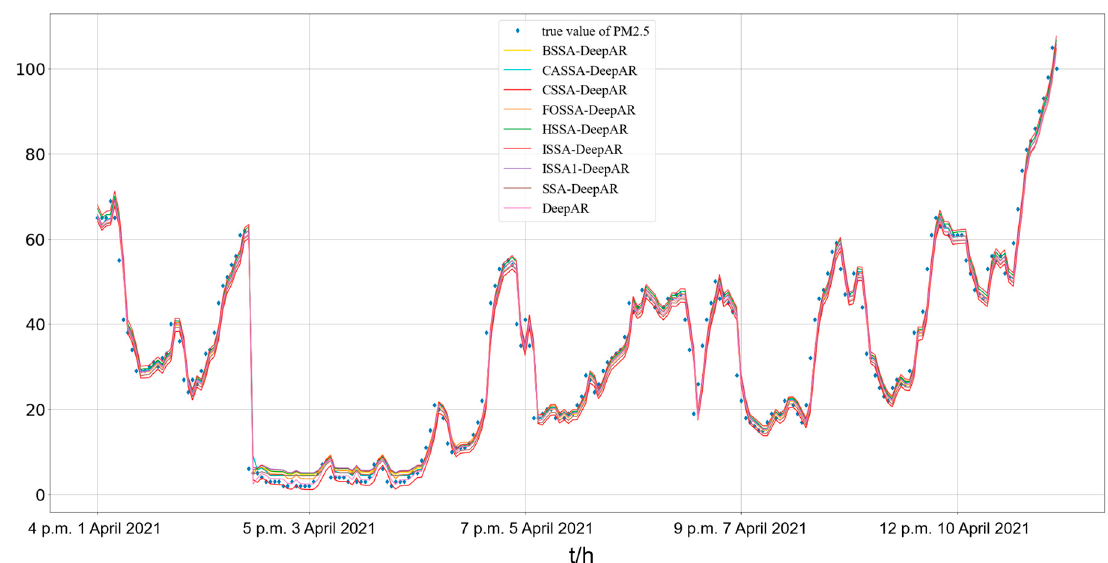
Figure 5. Point prediction results and true values of PM2.5 concentration in Beijing. In the nine prediction models, the point prediction result of FOSSA–DeepAR outperforms other models.